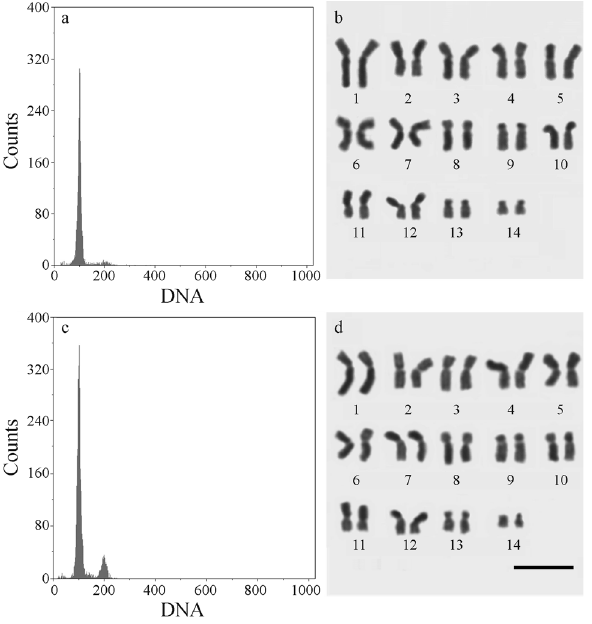
Figure 1 - Genome size DNA-histograms and karyotype (Giemsa stain- ing) of female (a and b) and diploid male (c and d) of Lestrimelitta sp. Bar = 5 (cid:2)